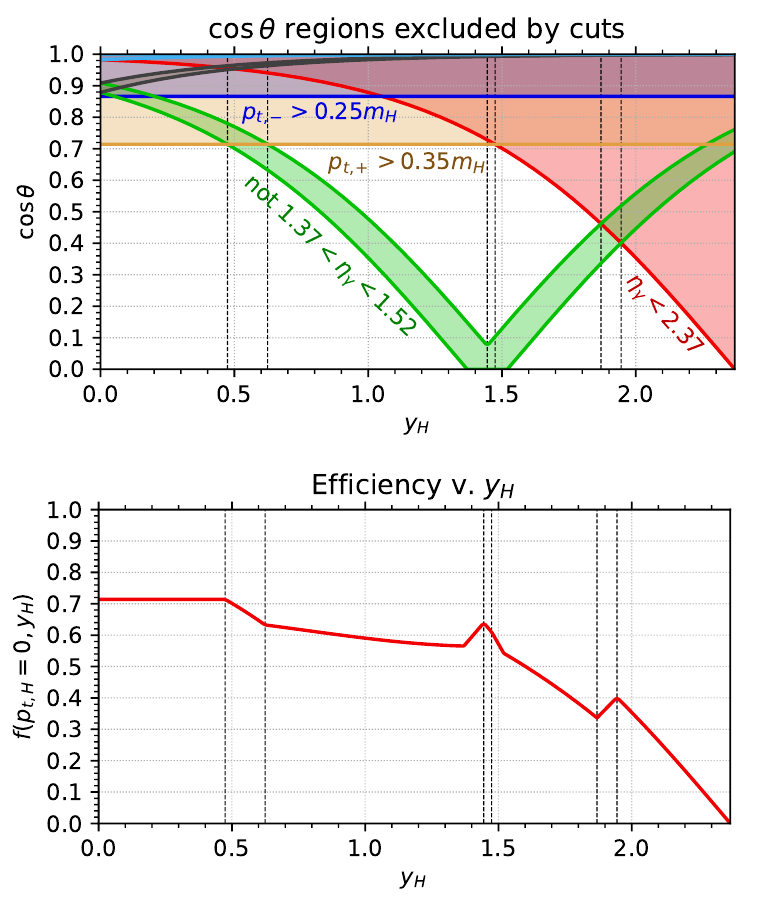
Figure 8 . Upper plot: the cos θ regions that are excluded by the main relevant photon p t and rapidity cuts, as a function of the Higgs boson rapidity y h , for p t, h = 0 . The vertical lines indicate the y h values where pairs of cuts have equivalent actions, i.e. corresponding to the special cases outlined in sections 4.2 and 4.3. The lower plot shows the Born ( p t, h = 0 ) acceptance with these cuts, as a function of y h